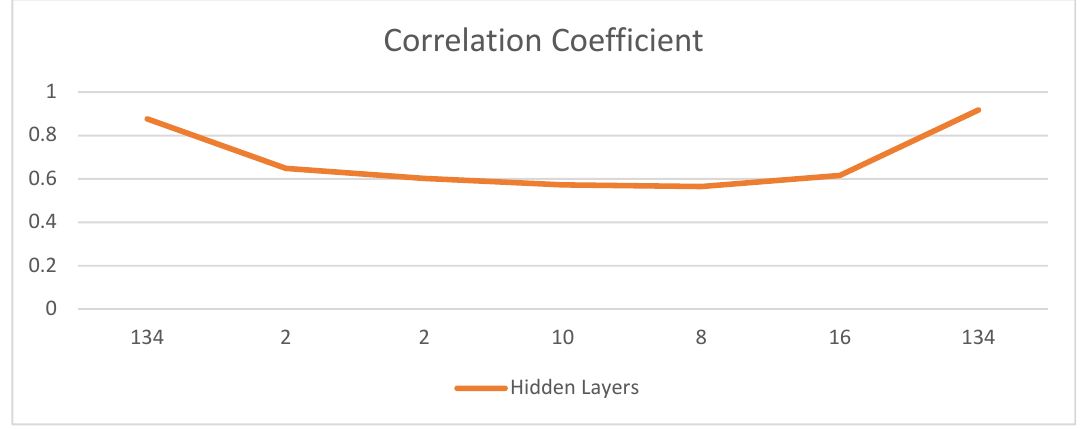
Figure 6. The correlation coefficient.